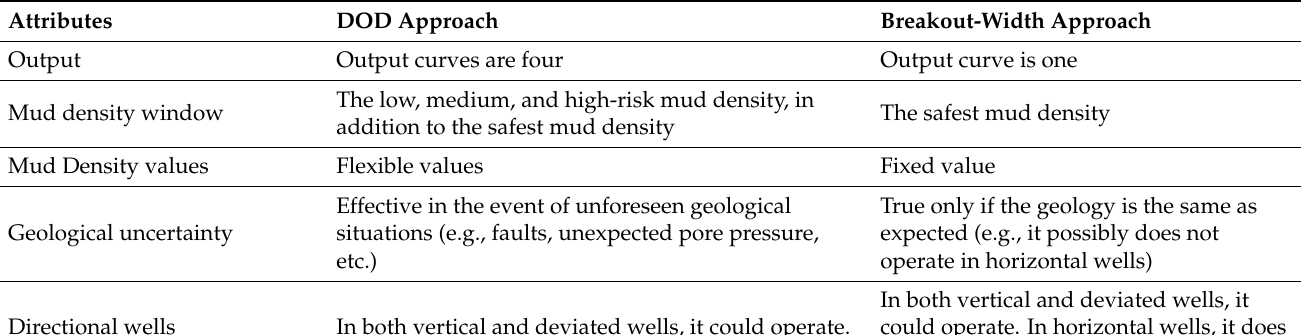
Table 4. The breakout-width concept versus the depth-of-damage